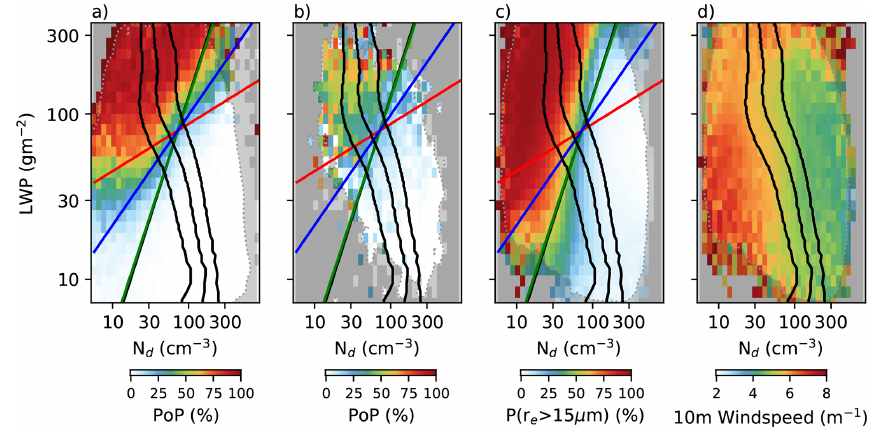
Figure 5. (a) The CloudSat probability of precipitation as a function of N d and LWP at a pixel (1km) resolution. The lines are contours of constant autoconversion rate from Tripoli and Cotton (1980, red), Liu and Daum (2004, blue), and Khairoutdinov and Kogan (2000, green). Panel (b) is the same as (a) but for N d and LWP at a 1 ◦ by 1 ◦ resolution. (c) The proportion of liquid r e retrievals > 15µm for N d and LWP at a 1 ◦ by 1 ◦ resolution. (d) The average ERA5 wind speed as a function of LWP and N d . Regions with fewer than 30 retrievals per bin are shaded